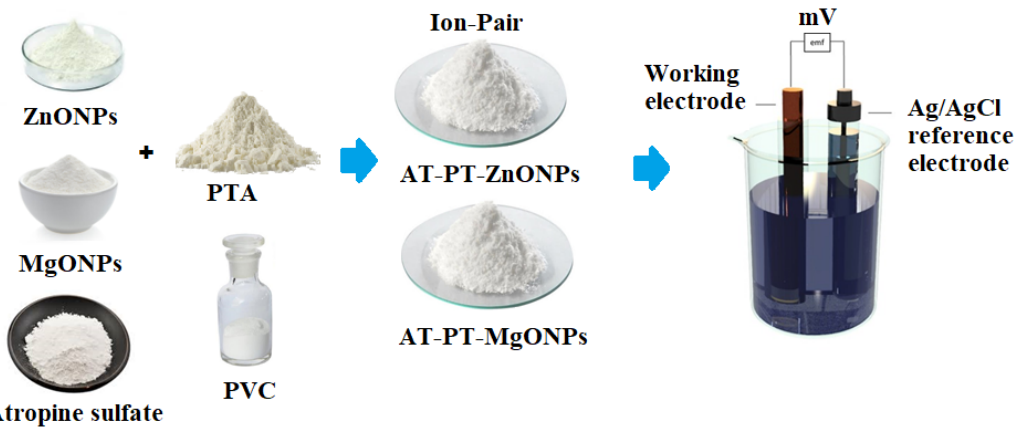
Figure 2. The preparation of modified AT-PT-ZnONP or AT-PT-MgONP sensors and the potentiometric system.